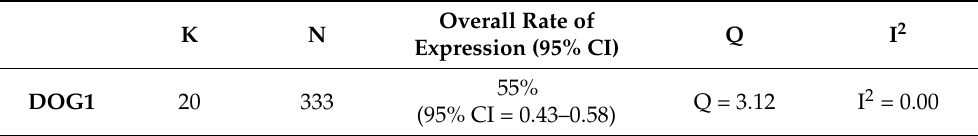
Table 4. Summary of meta-analytic